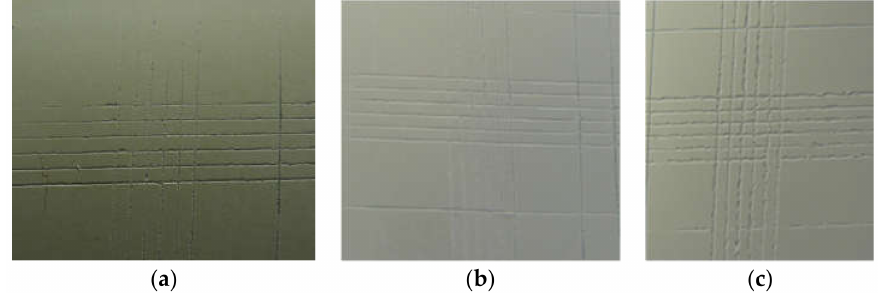
Figure 11. Appearance of the surface affected by the cross-cut area performed after the radiation with temperature and humidity test, for ( a ) the sample with sand from Ouarzazate, ( b ) the sample with sand from Dubai, and ( c ) the sample without sand.